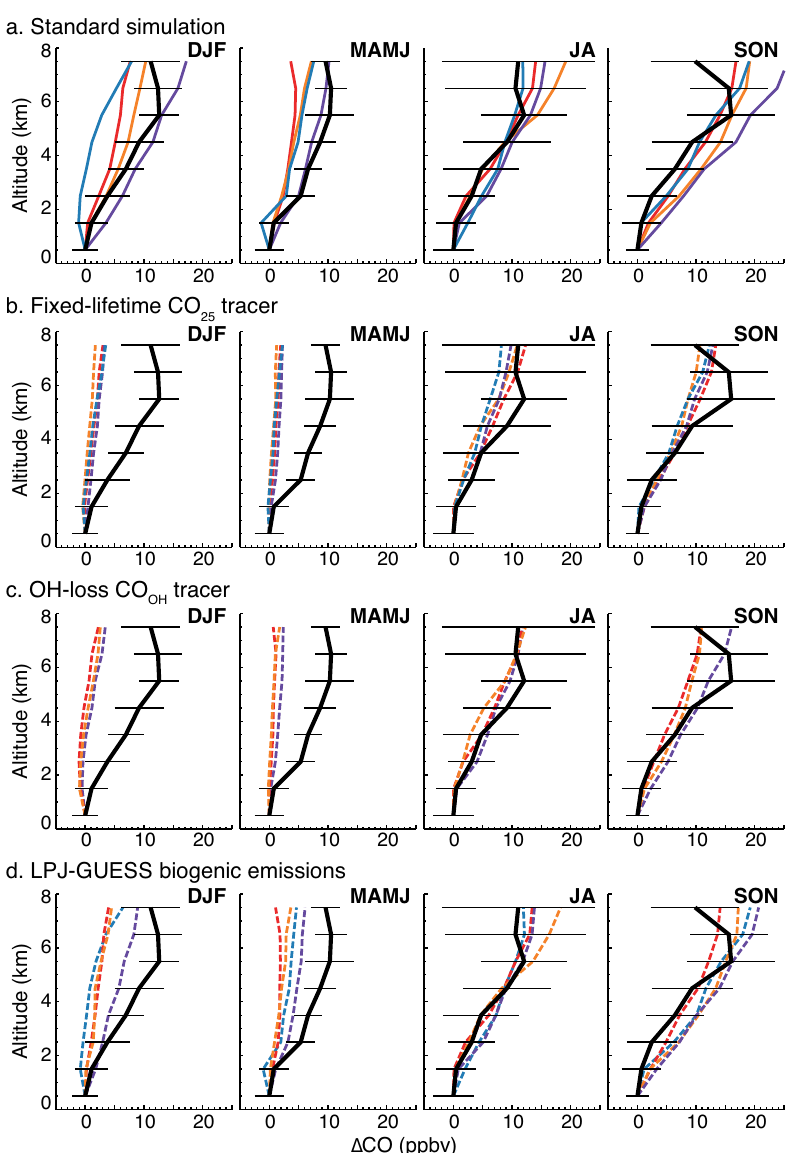
Figure 6. Median CO profiles from CGOP observations (black) compared to model simulations for 2004–2005 using (a) the standard simulation; (b) a global CO-like tracer with a 25-day lifetime (CO 25 ; see text); (c) a global CO-like tracer with OH-driven loss but no secondary production (CO OH ; see text); and (d) LPJ-GUESS isoprene and monoterpene emissions. Solid colored lines represent the standard simulations and dashed lines the sensitivity simulations for GEOS-Chem (red), NIWA-UKCA (orange), TM5 (purple), and CAM-chem (blue; no OH-loss tracer). Profiles are shown as (cid:49) CO, the deviation (in ppbv) from the observed or modeled value in surface air in each season, with the surface value calculated separately for each sensitivity